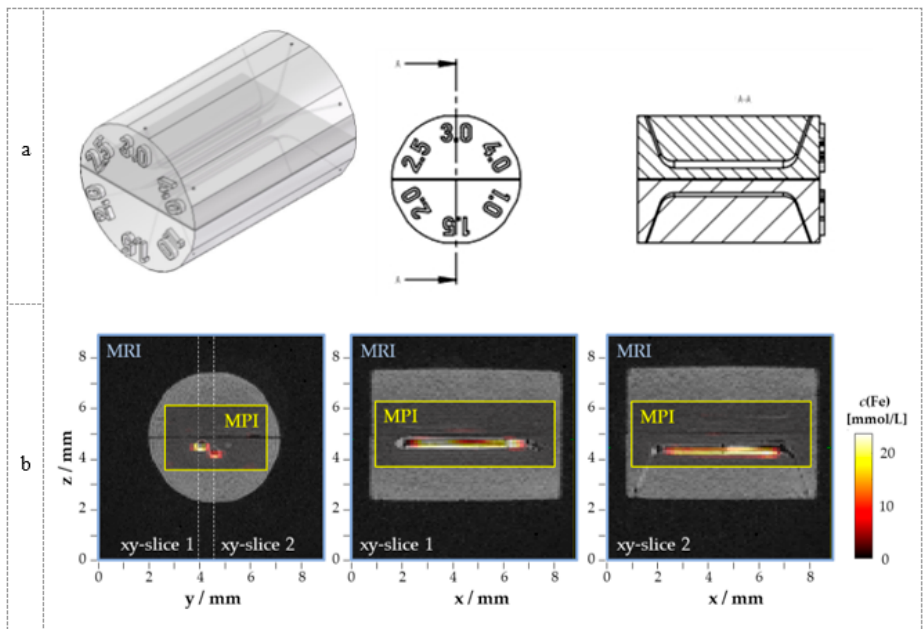
Figure 5. Phantom made of BioTec material (Dreve) for MPI and MRI imaging which contains capillaries with a diameter of 1, 1.5, 2, 2.5, 3, and 4 mm ( a ). MRI (blue border) and MPI (yellow border) results of the designed phantom with BioTec material are shown as image fusion ( b ). For MPI, a dedicated tracer (Synomag ® , c (Fe) = 19.5 mmol/L) was filled into the 3 mm and 4 mm capillaries for imaging with MPI.